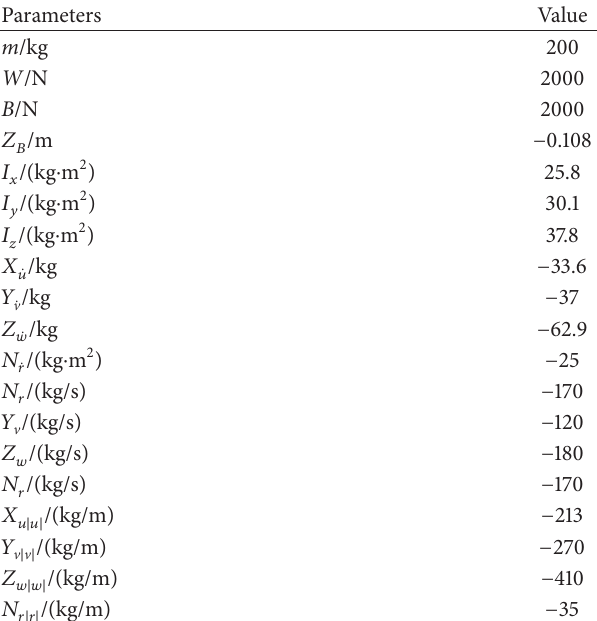
Table 1: Nominal physical parameters of the ROV.